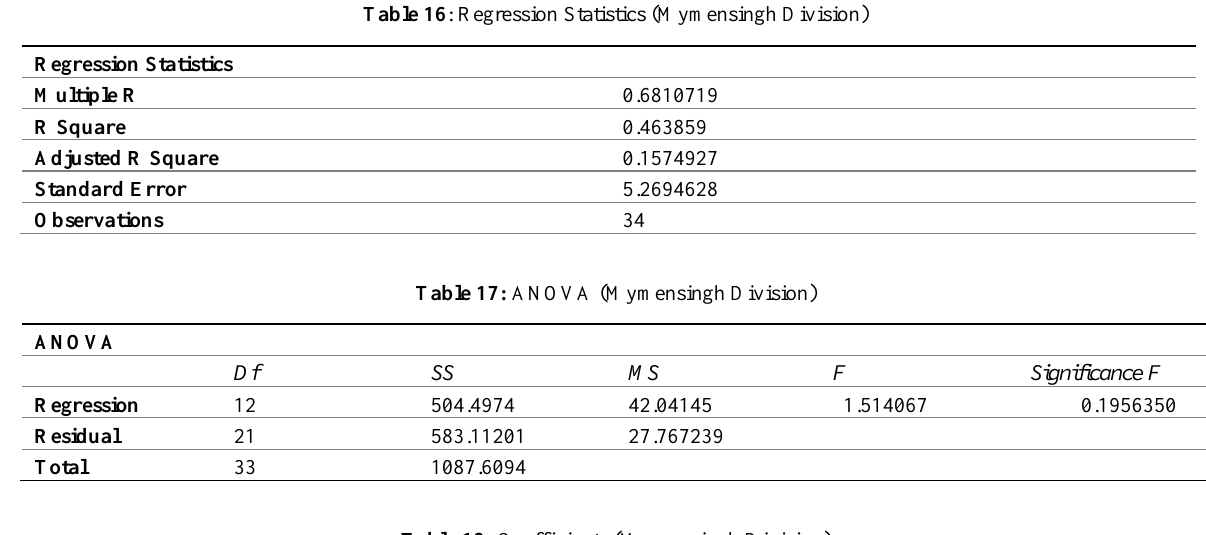
Table 18: Coefficients (Mymensingh